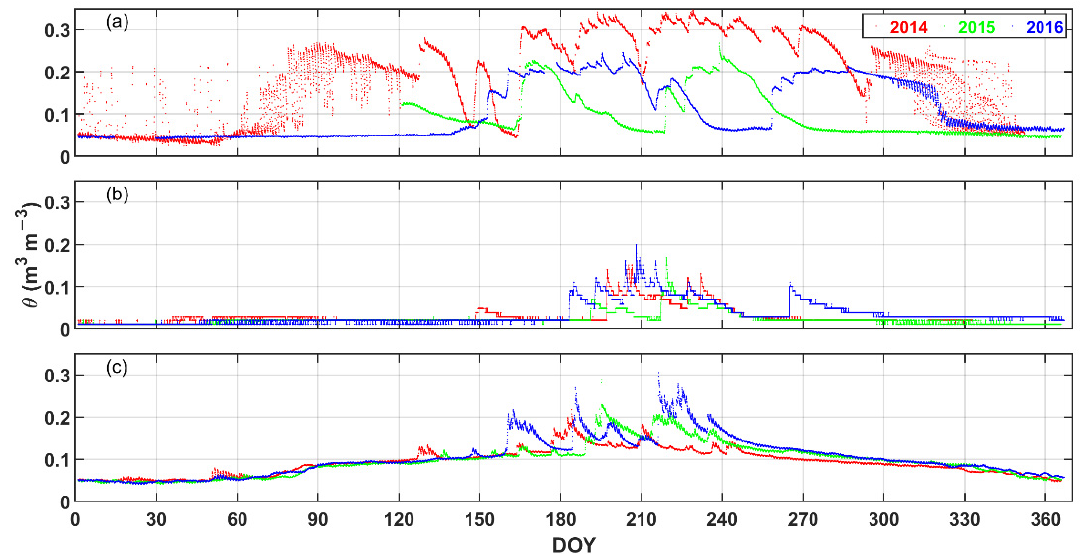
Figure 2. The variations of hourly soil moisture ( θ , m 3 m − 3 ) at the depth of 0.10 m at ( a ) BJ, ( b ) QOMS, and ( c ) NADORS for 2014–2016. Note that θ was measured at 0.04 m depth at BJ 2014, θ at NADORS were the arithmetic mean of soil moisture measured at the depths of 0.00 m and 0.20 m, and θ were directly measured at the 0.10 m depth for other